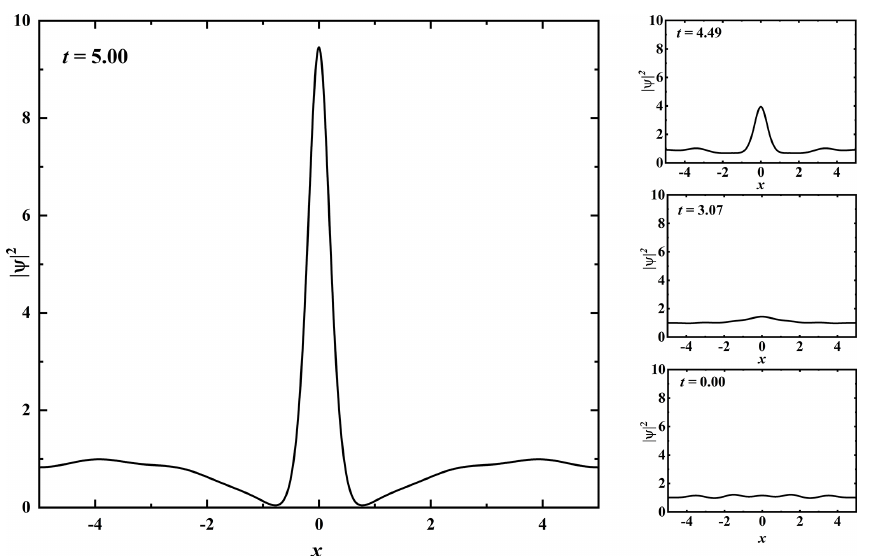
Figure 6. Numerical calculation of the Peregrine soliton using the approach of Yang (2010) and Ward et al. (2019). The solution is an extreme end-member short-wavelength and short-timescale compression of wave energy | ψ | 2 . In the context of the selected parameters the soliton is understood as a fluid pressure spike likely to cause unstable slip on a pre-existing (near-critically stressed) fault plane that triggers the ultimate (shear) seismic moment